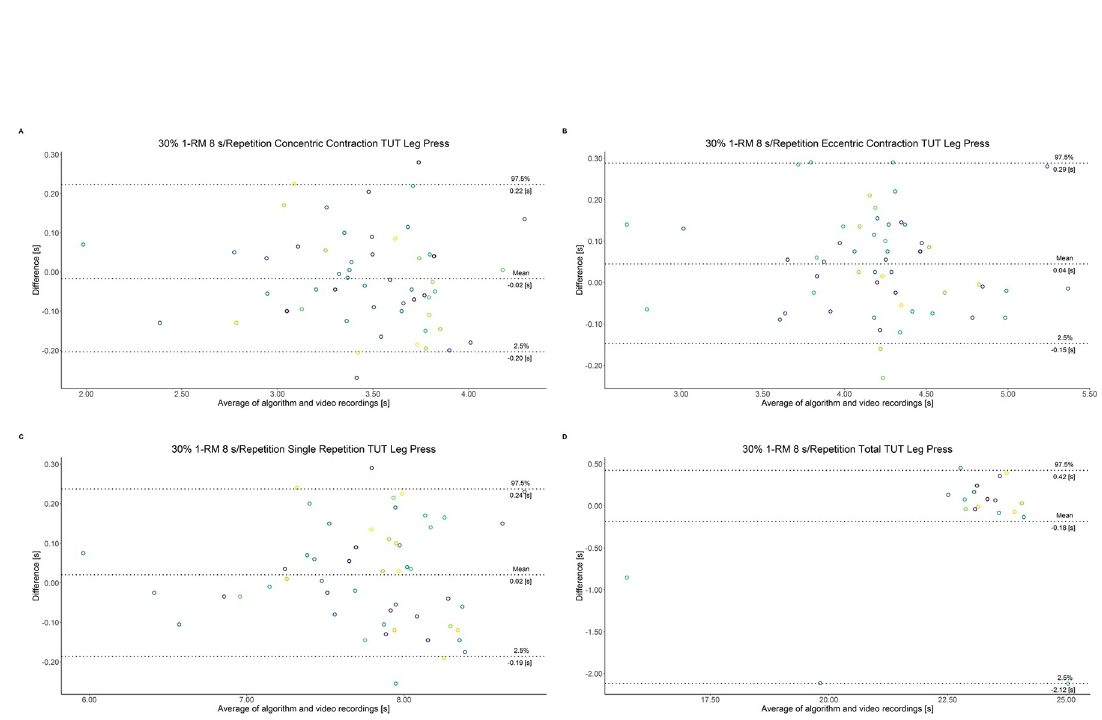
Fig 10. Bland-Altman plots of agreement between algorithmically accelerometer derived and video recordings derived contraction-specific phases of the leg press machine at 30% 1-RM with a velocity of 8 s per repetition. A: Concentric contraction phase. B: Eccentric contraction phase. C: Single repetition. D: Total time-under-tension.